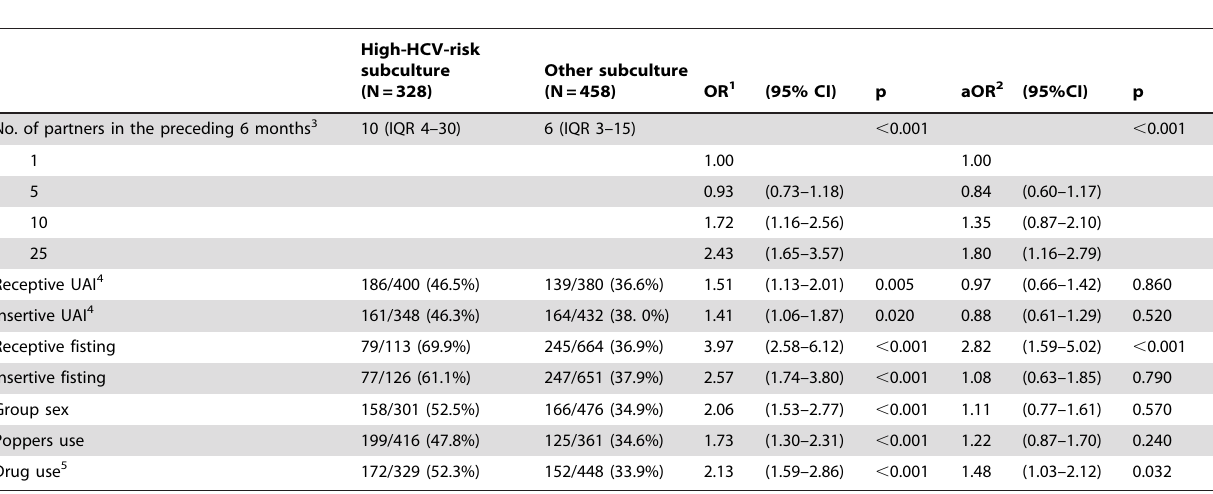
Table 4. Sexual behavior associated with a high-HCV-risk subculture (i.e., leather, rubber/lycra, or jeans) among 786 HIV-infected MSM, Amsterdam,